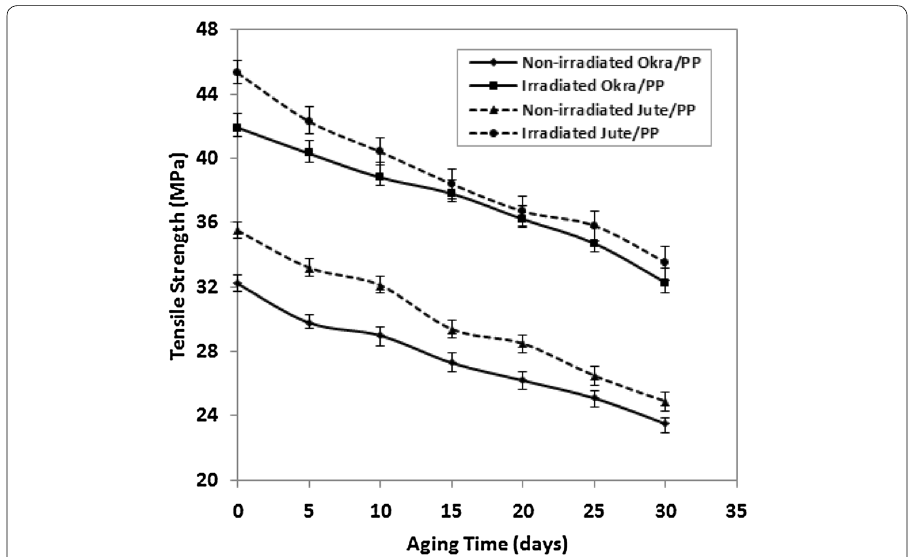
Fig. 10 Tensile strength of non-irradiated and irradiated (500 krad) composites against aging time